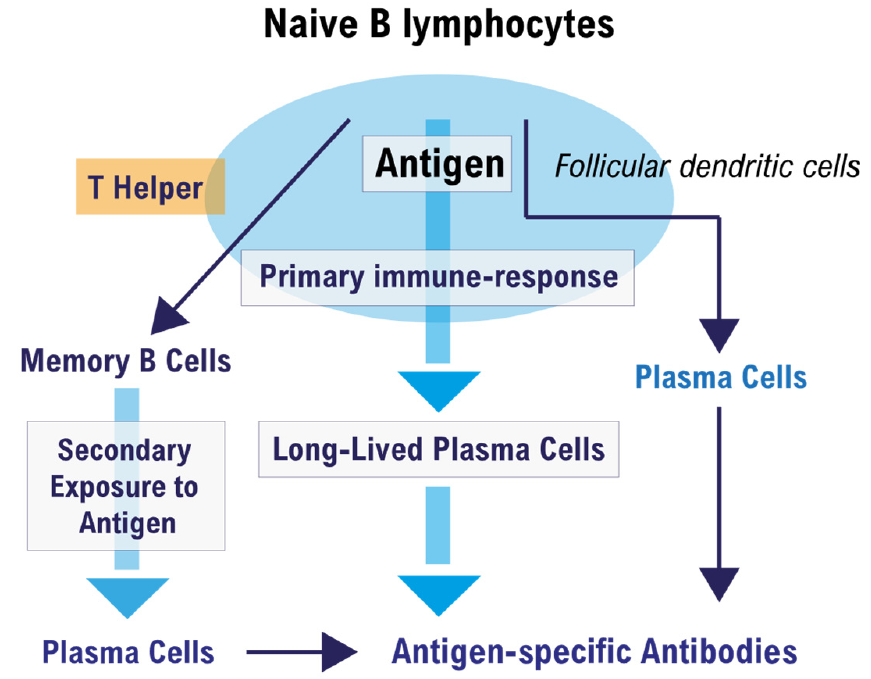
Figure 1. Fate of a naïve B cell after encountering the antigen in the germinal center. A naïve B cell present in the lymph nodes and spleen, when activated for the first time by the complementary T-dependent antigen, undergoes a series of modifications that occur essentially in the germinal center (GC) of the peripheral lymphoid organs (Figure 1). In the GC, T-helper lymphocytes, follicular dendritic cells (FDCs), and antigen-activated B lymphocytes are encountered, and together they produce a primary immune